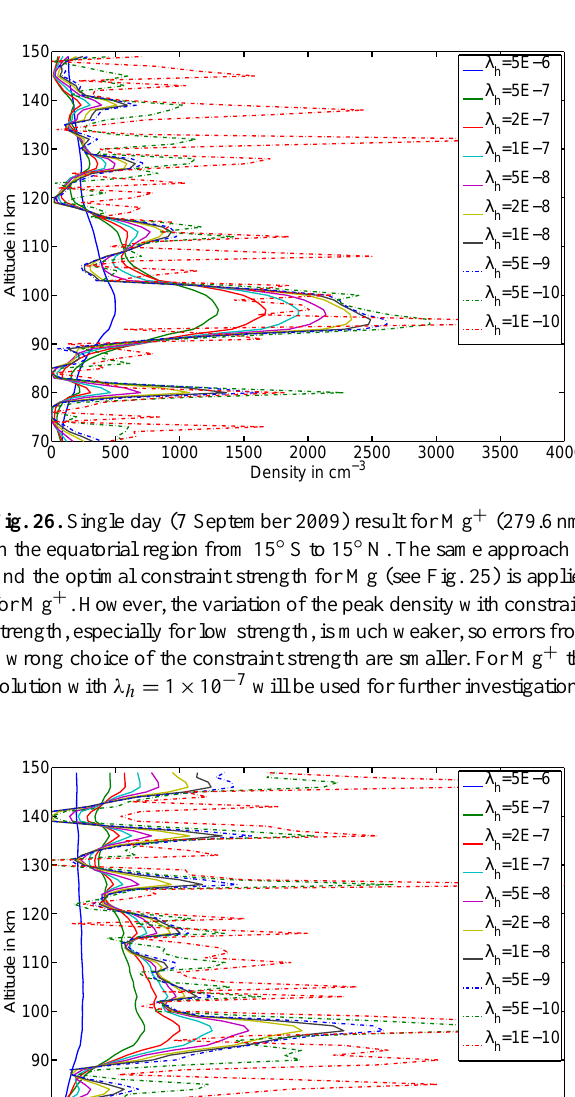
figures show results for Mg). For simplicity a 1-D pure